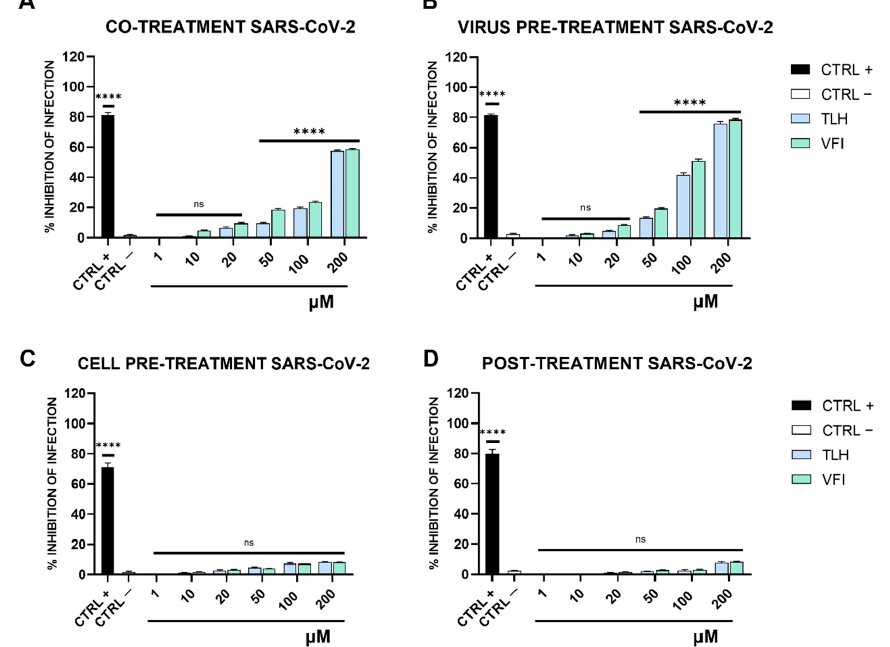
Figure 2. Antiviral activity of tripeptides against SARS-CoV-2. ( A ) co-treatment; ( B ) virus pre-treatment; ( C ) cell pre-treatment; ( D ) post-treatment. CTRL+ refers to positive control (ivermectin 12 μ M) and CTRL—indicates the negative control (only infected cells); **** p ≤ 0.0001; ns: non-significant. Both peptides reduced SARS-CoV-2 infection up to 60% at 200 μ M when they were